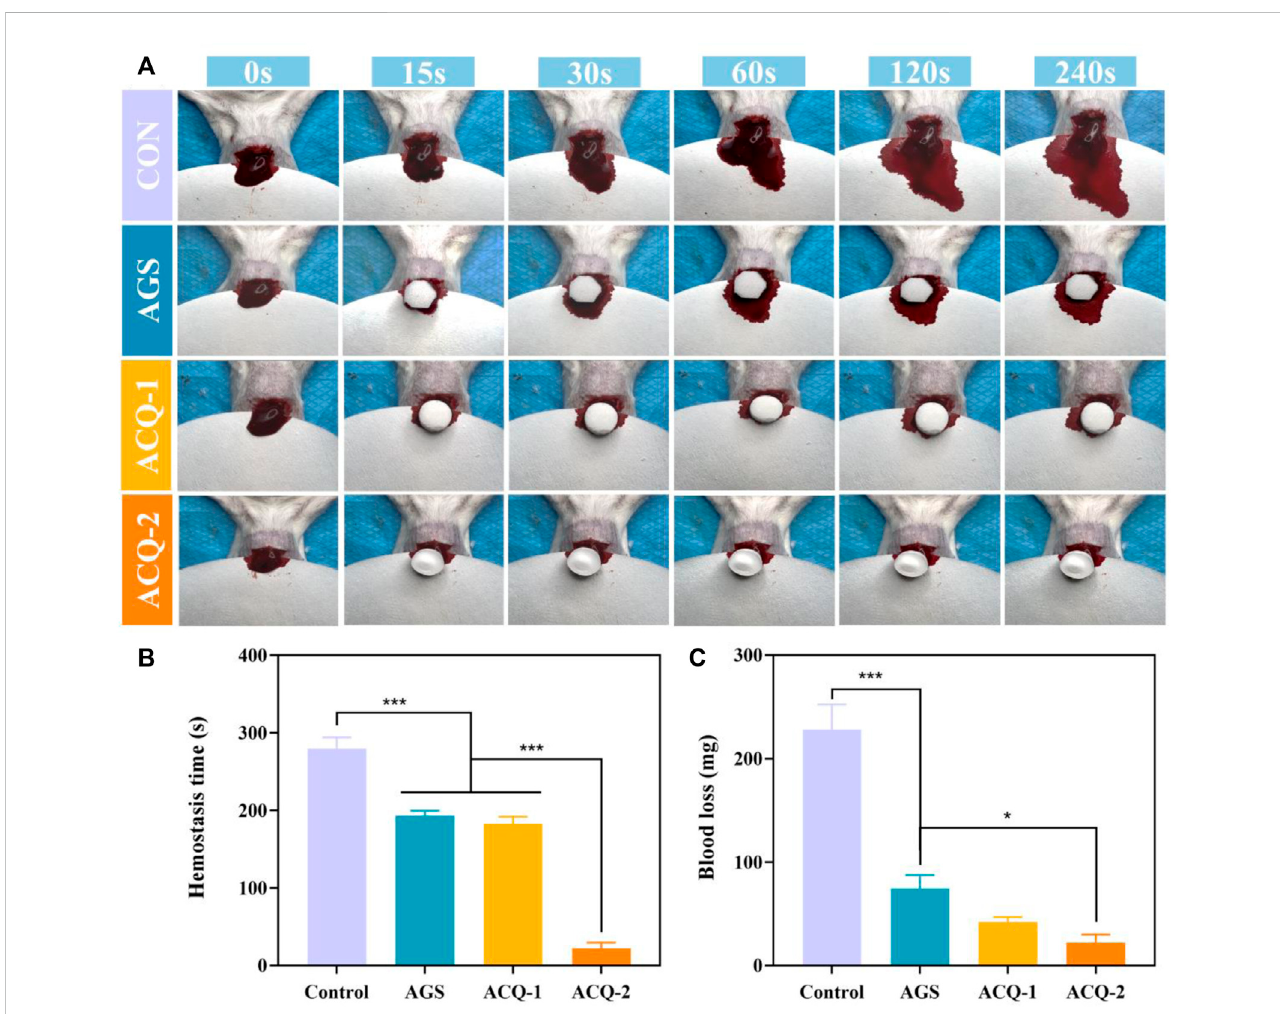
FIGURE 7 (A) Photographs of blood fl ow taken at speci fi c times during liver hemostasis experiments. (B) Blood loss and (C) hemostasis time in liver hemostasis experiments. Data are mean ± SD (n = 3) (* p < 0.05, *** p < 0.001).